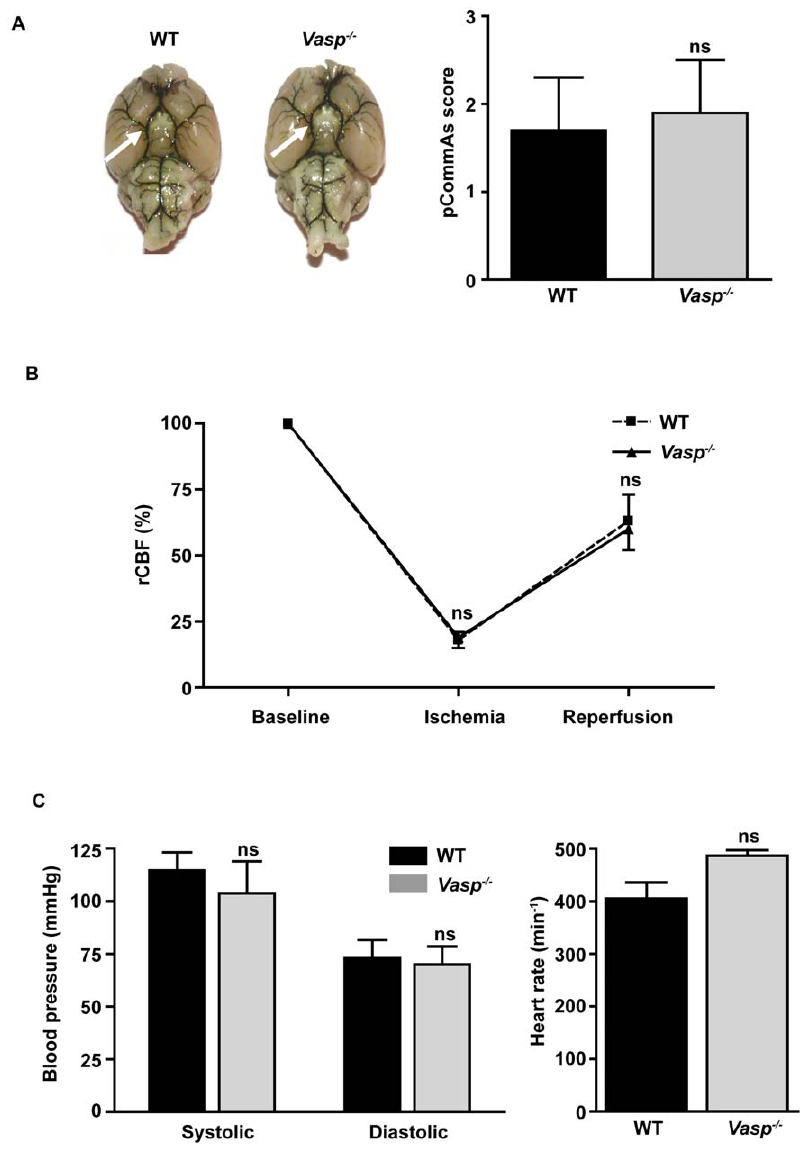
Figure 1. Vasp deficiency does not alter anatomical and physiological parameters relevant for stroke outcome. ( A ) (left) A complete Circle of Willis (arrows) was present in wild-type (WT) and Vasp 2 / 2 mice and the trunk and branches of the middle cerebral artery (MCA) were similar in both groups as depicted by ink perfusion. (right) The formation of the posterior communicating arteries (PComAs) was quantitatively assessed under a microscope in both mouse groups. The PComAs score did not differ between Vasp 2 / 2 mice and WT controls (n=5/group), p . 0.05; unpaired, two-tailed Student’s t-test compared with WT mice. ( B ) rCBF in the MCA territory was measured by Laser Doppler flowmetry before (baseline) and immediately after MCAO (ischemia), and again 10 min after removal of the occluding filament (reperfusion). No significant differences in rCBF were observed at any time point between WT and Vasp 2 / 2 mice (n=5/group); p . 0.05. Bonferroni-corrected 2-way ANOVA compared to baseline rCBF. ( C ) Systolic and diastolic blood pressure (RR) (left) as well as heart rates (right) are similar in Vasp 2 / 2 mice and WT controls, p . 0.05; unpaired, two-tailed Student’s t-test compared with WT mice. ns: not significant.